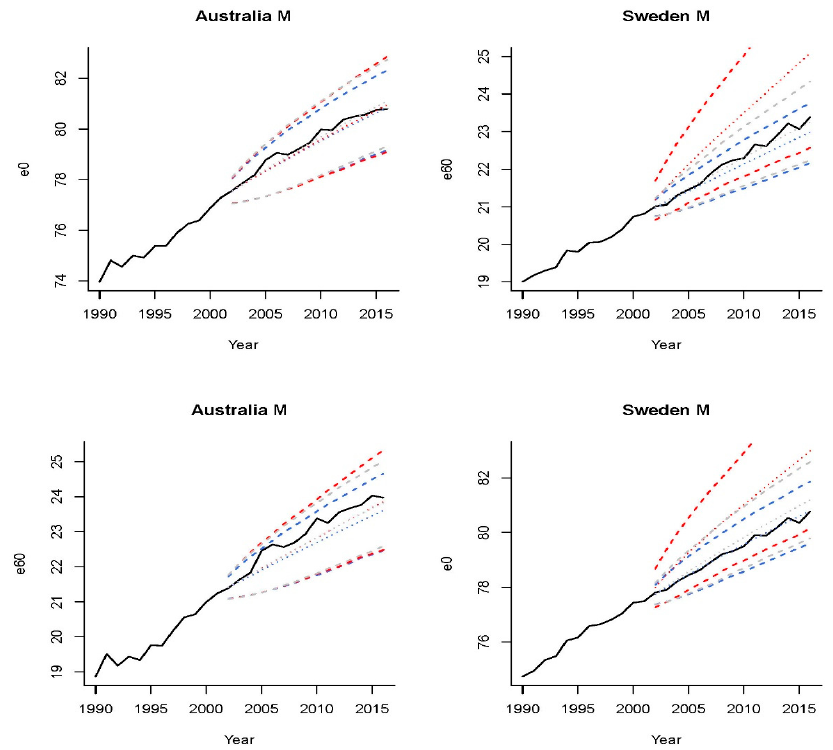
Figure 10. Observed values (solid lines), projected values (dotted lines) and 95% prediction intervals (dashed lines) of life expectancies at birth (top panel) and age 60 (bottom panel), calibrated on years 1950-2001. The blue lines correspond to the projections from the original Lee-Carter model, and the red (grey) lines refer to the projections from the Fourier (cubic) Lee-Carter model. The mortality index is modelled as piecewise RWD.